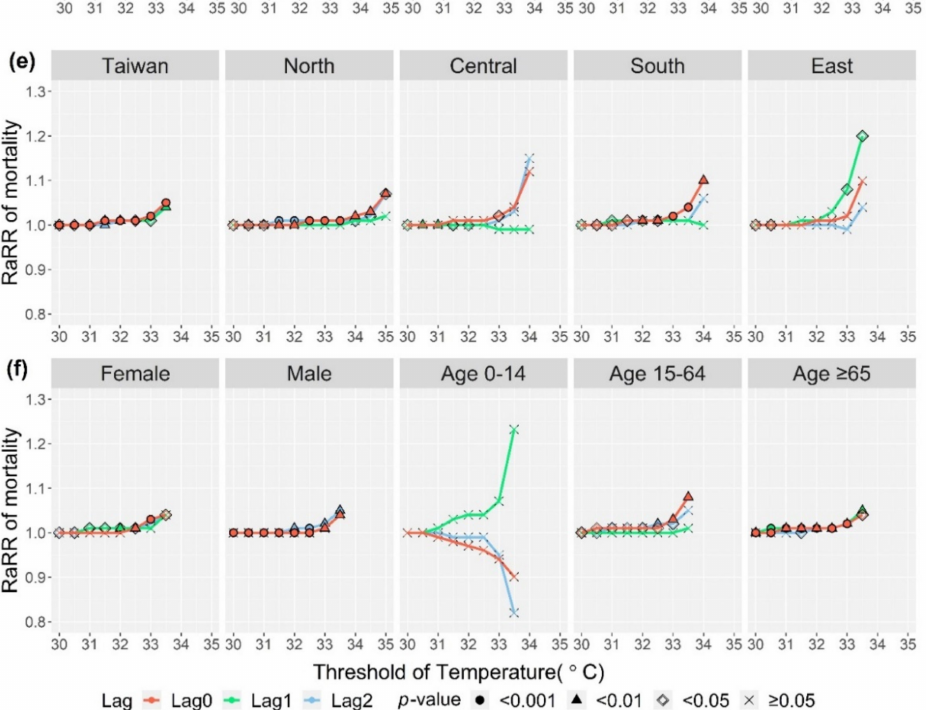
Figure 3. Reference-adjusted risk ratios (RaRRs) of heat-related emergency visits, heat-related hospital visits, and all-cause mortality at different temperature threshold candidates for the whole of Taiwan and different sub-regions ( a , c , e ), and different sex and age ( b , d , f ). p -values are those for the corresponding relative risks at that threshold